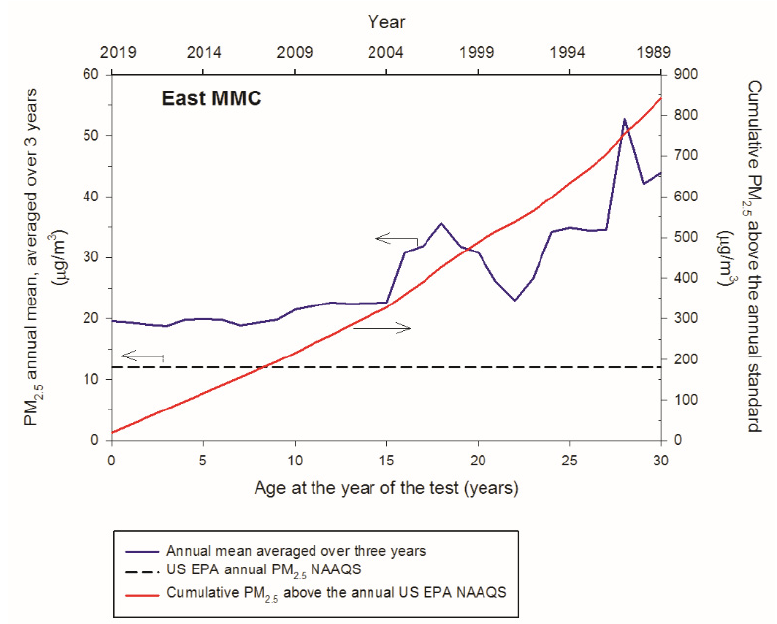
Figure 2. Backward annual trends of the PM 2.5 annual mean concentrations averaged over three years and the respective cumulative PM 2.5 concentrations determined for the east sector of MMC according to the age of the volunteers at the year of the study (2019). The average annual PM 2.5 exposure was calculated as 33.4 µg/m 3 /year.